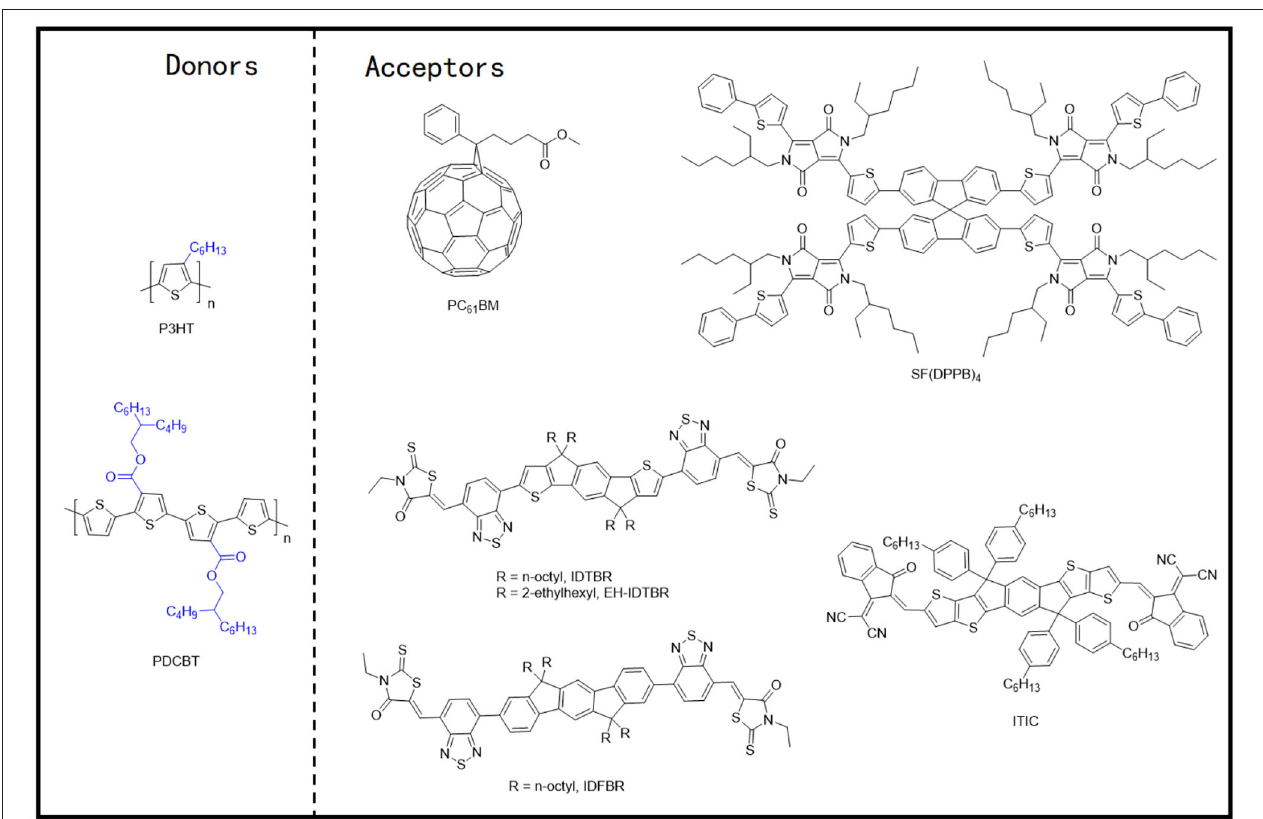
FIGURE 3 | Molecular structures of the representative polythiophene derivatives and mentioned